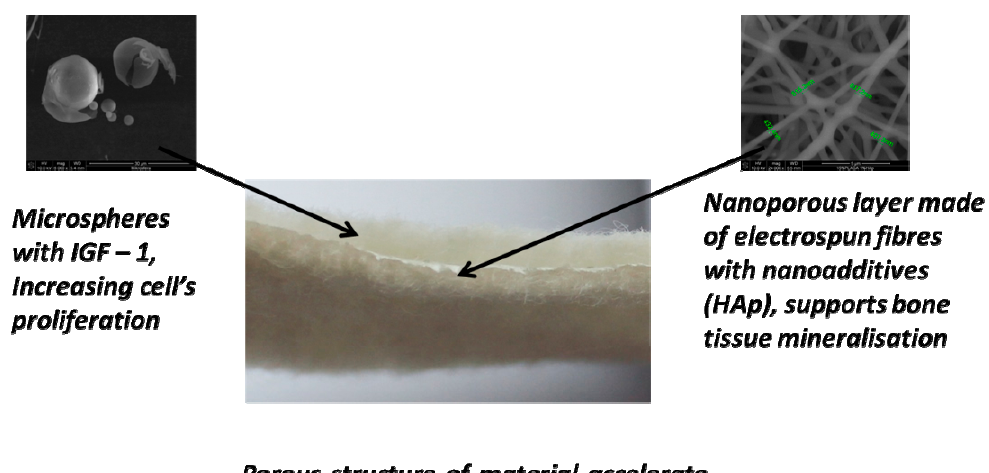
Figure 1. Structure of the implants for osseous tissue regeneration.